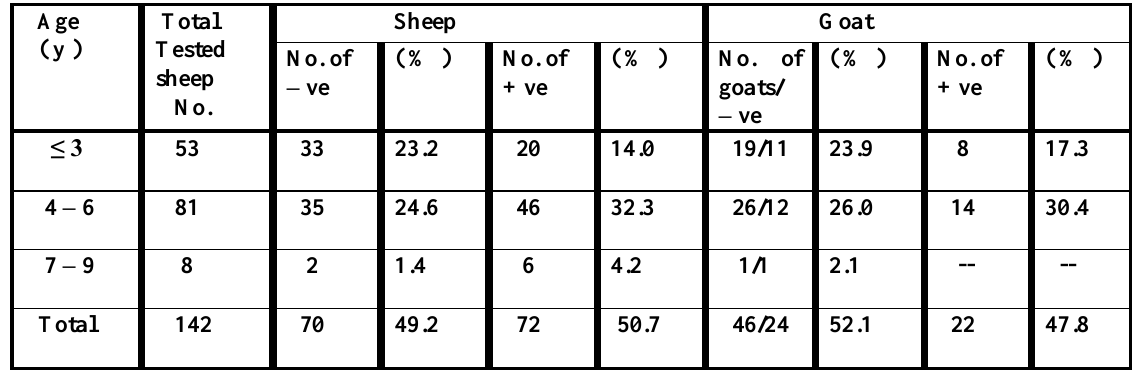
Table (2) prevalence of toxoplasmosis in different ages between sheep and goats by